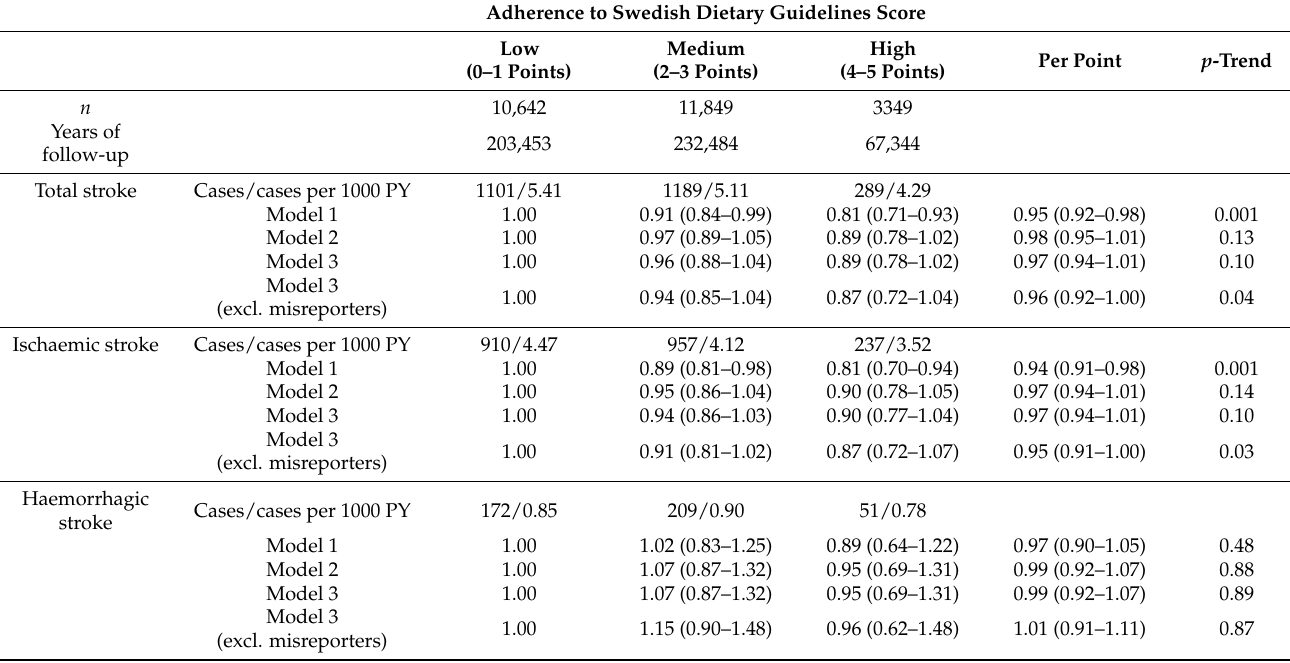
Table 3. Association (HR and 95% CI) between Swedish dietary guidelines score and risk of stroke. Adherence to Swedish Dietary Guidelines Score